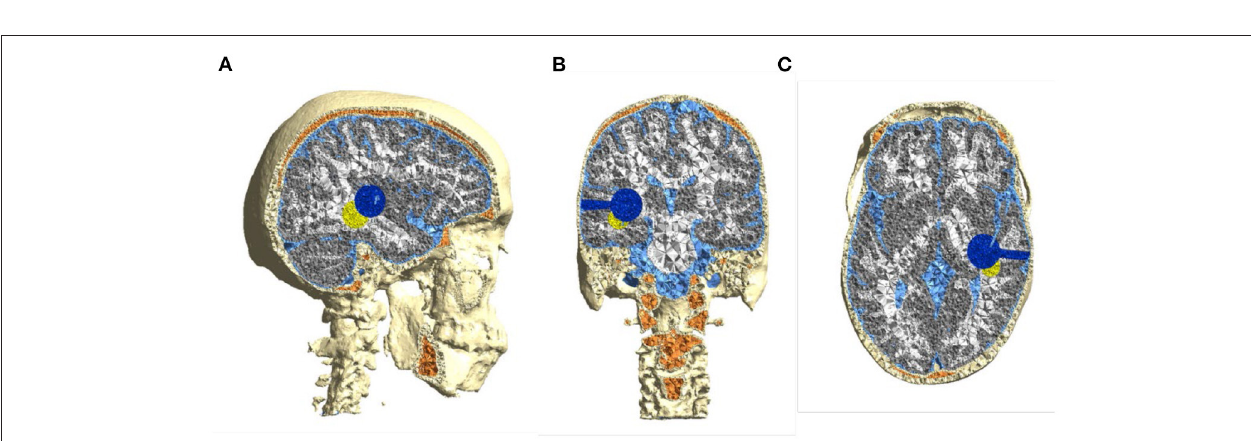
FIGURE 2 | Computational head model based on healthy subject’s (“Ernie”) MRI— (A) sagittal, (B) coronal, and (C) axial. Pathology features were inserted to mimic a real patient’s postoperative MRI, i.e., a spherical 2.5cm resection cavity and connected surgical corridor (blue) and a spherical 2.5cm residual tumor remnant